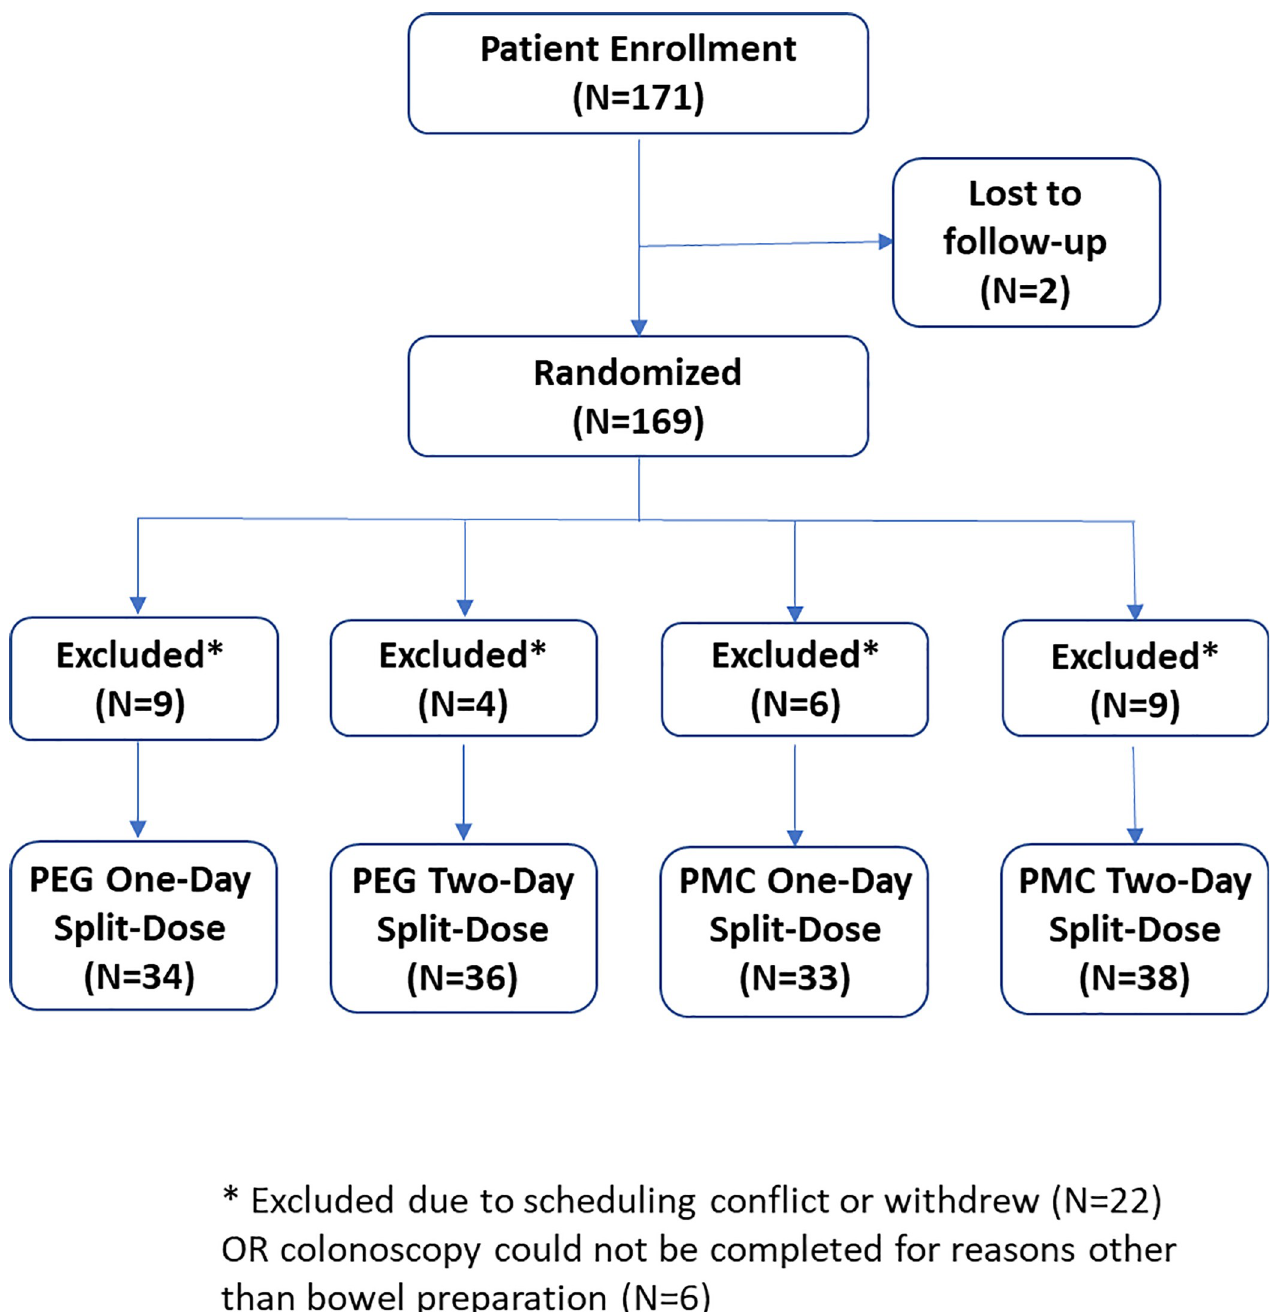
Fig 1. Study flow diagram. https://doi.org/10.1371/journal.pone.0211136.g001 70 patients received PEG and 71 received PMC. Table 2 shows the baseline characteristics of the two groups. PMC and PEG groups were well matched in terms of both age (57.6[95% CI:55.8,59.4] vs 56.4[95%CI:55.0,57.8]), P = 0.395) and sex (percent female: 47.8% vs 51.4%, P = 0.539). In the PEG group, 34(48%) patients received a one-day split regimen and 36(52%) patients received a two-day split regimen. In the PMC group, 33(46%) patients received a one-